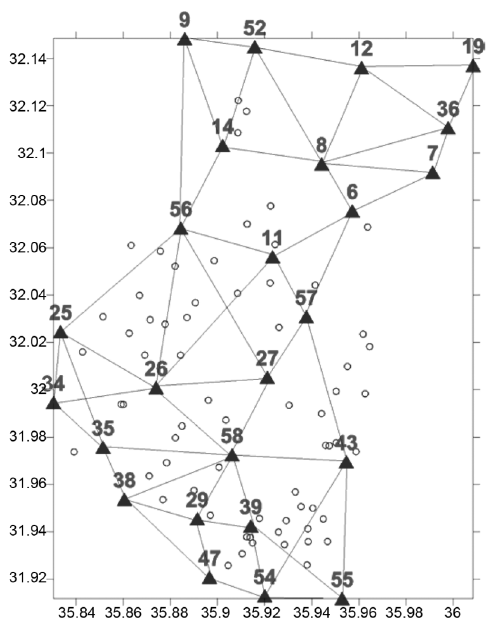
Fig. 3. GPS Static reference points and rapid static points (latitude and longitude in